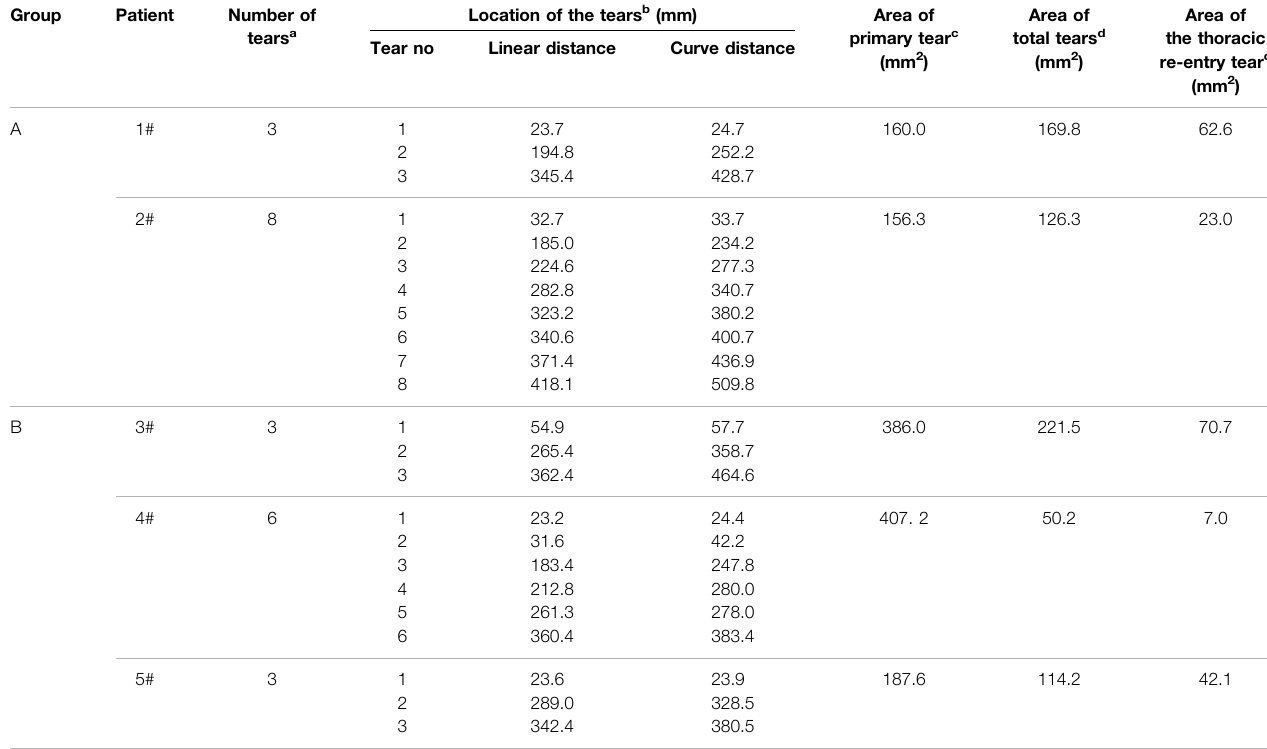
TABLE 1 | Tear information of patients included in this study. Group